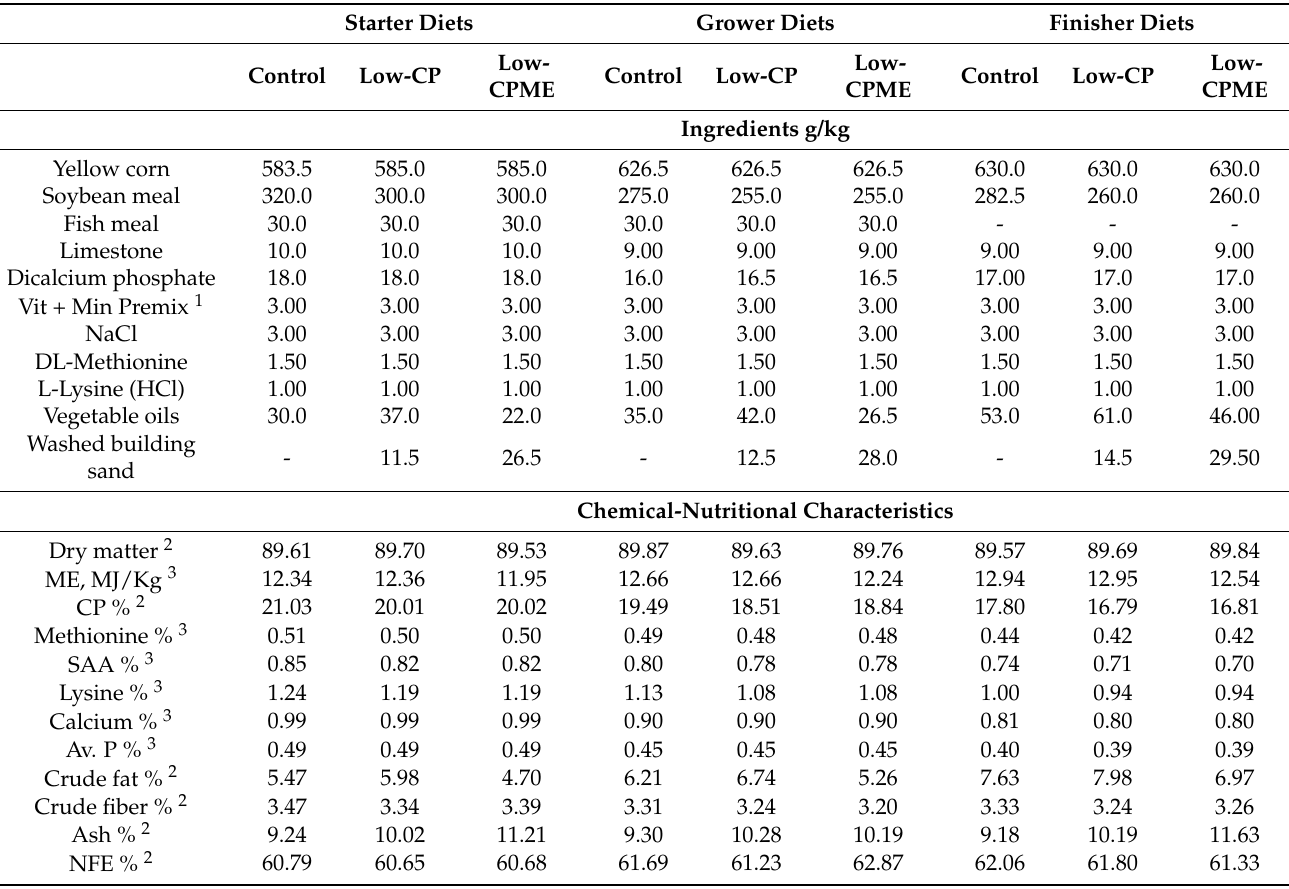
Table 1. Ingredients and chemical-nutritional characteristics of the diets used along the